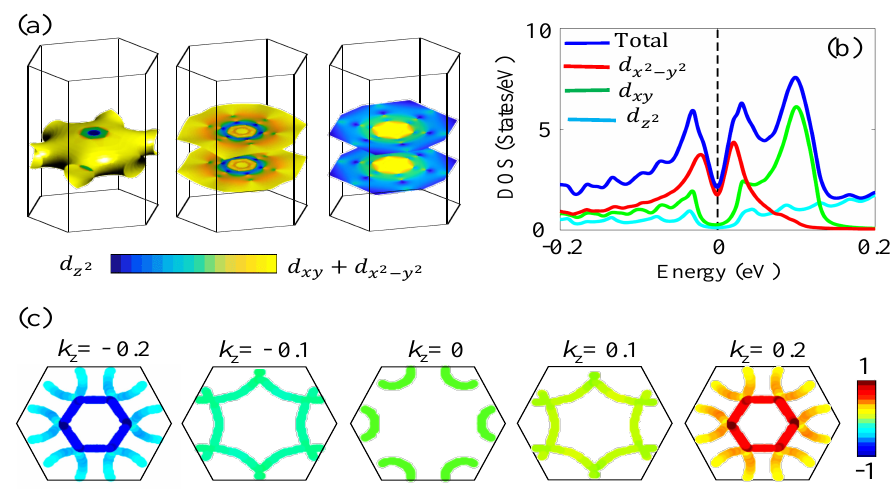
Figure 4. Theoretical results. ( a ) Three FS sheets are plotted separately for visualization. The blue to yellow colormap gives the orbital weight (see colorbar). ( b ) DOS in the SC state is plotted near the Fermi level. We have used an artificially large SC gap of 30 meV for visualization. Finite DOS at the Fermi level is an artifact due to finite broadening for numerical convergence. Blue color gives the total DOS, while other colors give orbital resolved DOS. ( c ) Two-dimensional FS cuts in various representative constant values of k z . The red to blue color gradient paints the corresponding pairing eigenstate ∆ ( k )